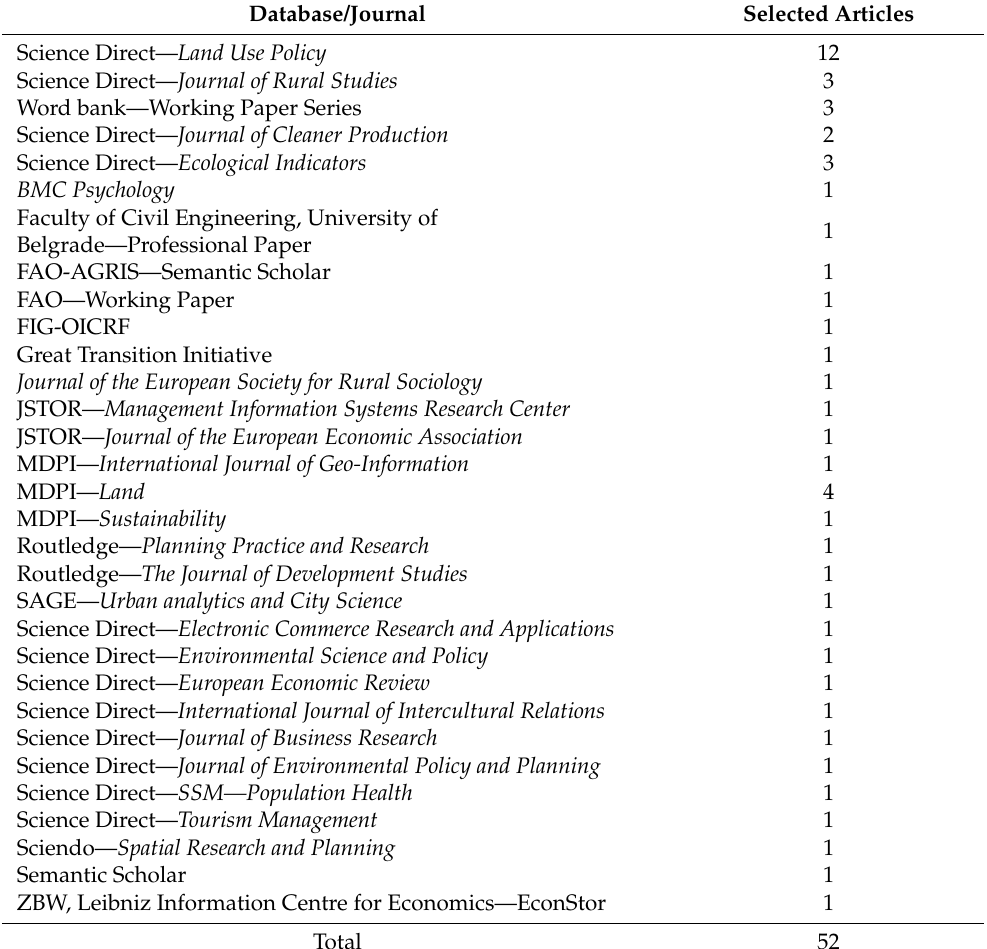
Table 1. Search results of the literature review. Number of articles found from the databases.